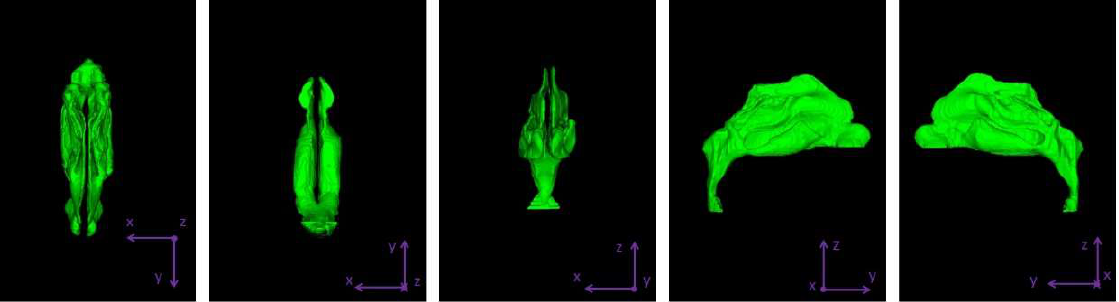
Figure 2. The 3D geometry of the nasal and nasopharyngeal cavities shown in various planes. The software used to segment the geometry from CT DICOM data was ITK-SNAP [20].